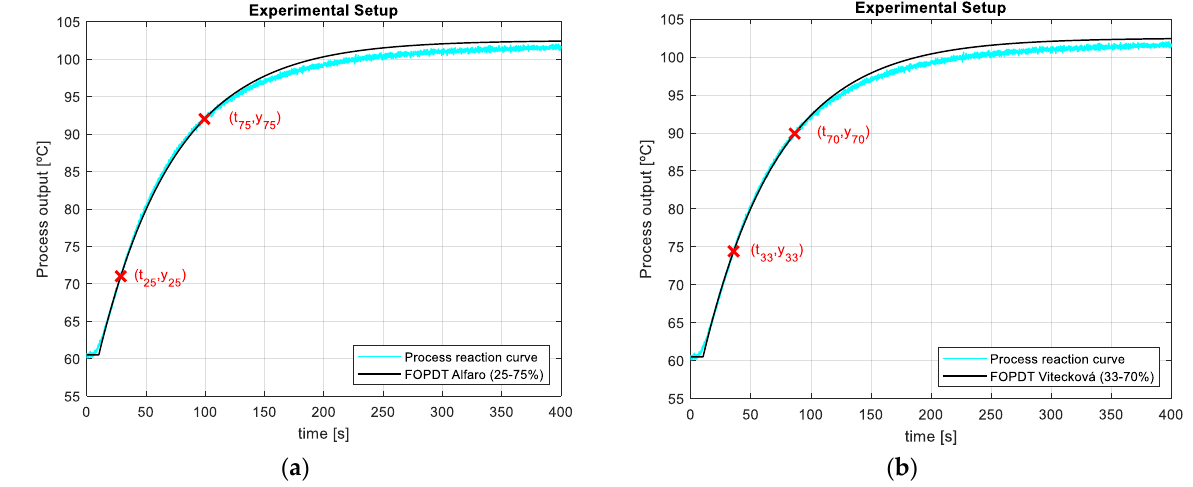
Figure 11. Process reaction curve in a certain operating point (Configuration #1) and FOPDT model step response using two-point identification methods for the experimental setup: ( a ) Method pro- posed by Alfaro in [46]; ( b ) Method proposed by Vitecková in [47].